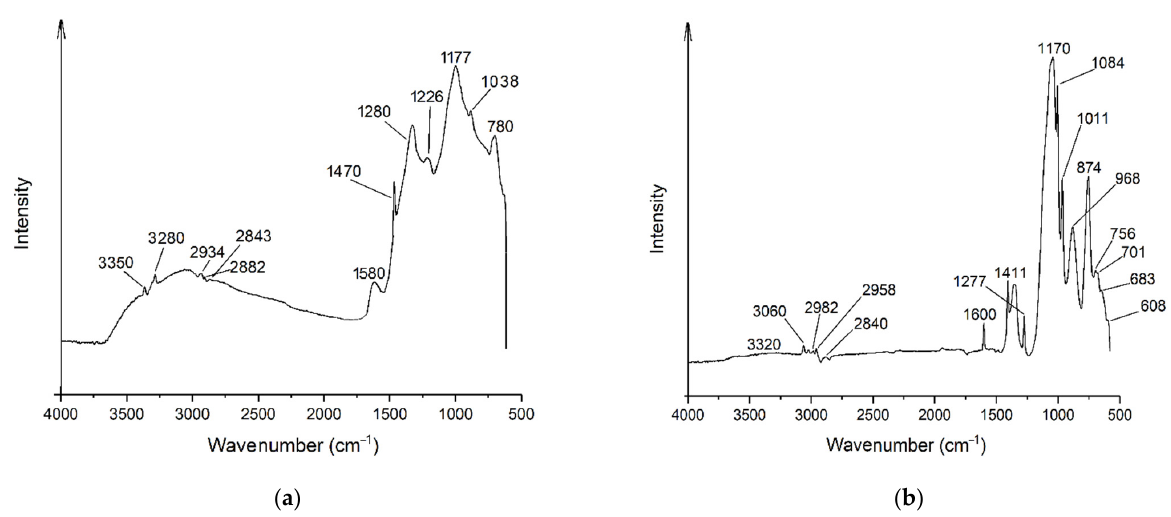
Figure 3. IR spectrums of films formed on the aluminium surface, after exposure metal samples for 60 min in organosilane solutions, in the region of 4000–500 cm − 1 : ( a ) DAS; ( b ) VS.